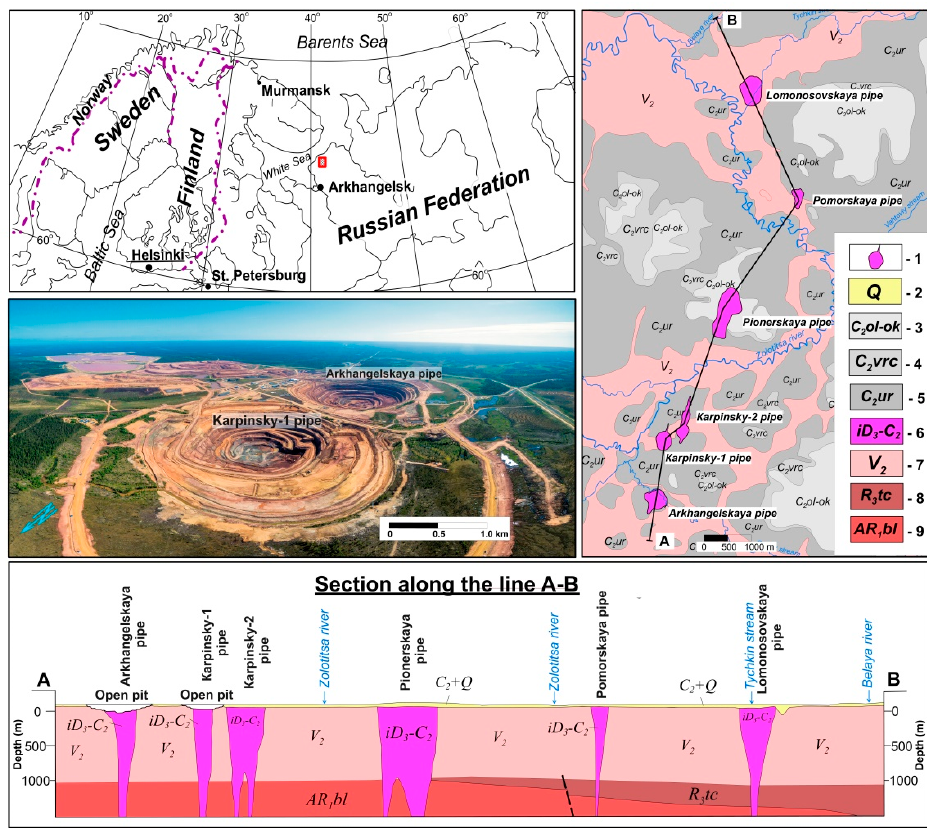
Figure 1. The location of the study area and the geological structure of the Lomonosov diamond deposit. 1—Kimberlite pipe; 2—Quaternary fluvioglacial sediments; 3–5—Middle Carboniferous sediments: 3—Olmugo–Okunev suite; 4—Voevchensky suite; 5—Ursug suite; 6—Kimberlites: Upper Devonian–Middle Carboniferous; 7—Upper Vendian sediments; 8—Upper Riphean: Tok- minskaya suite; 9—Archean: Belozersky